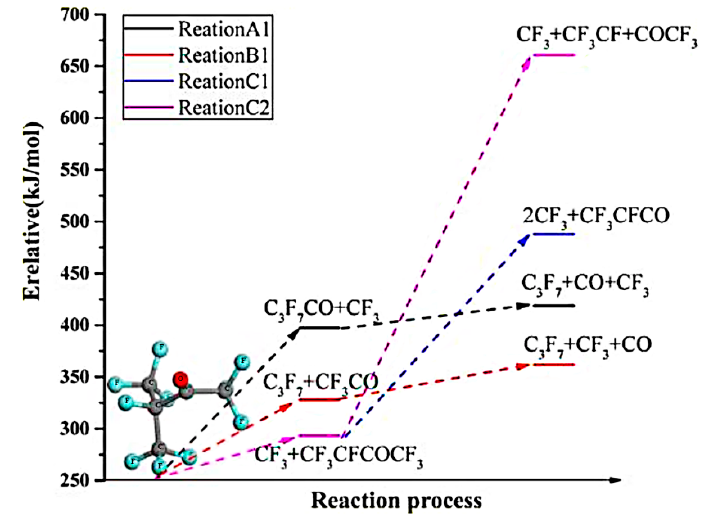
Figure 4. The main reaction paths of C 5 F 10 O [40].